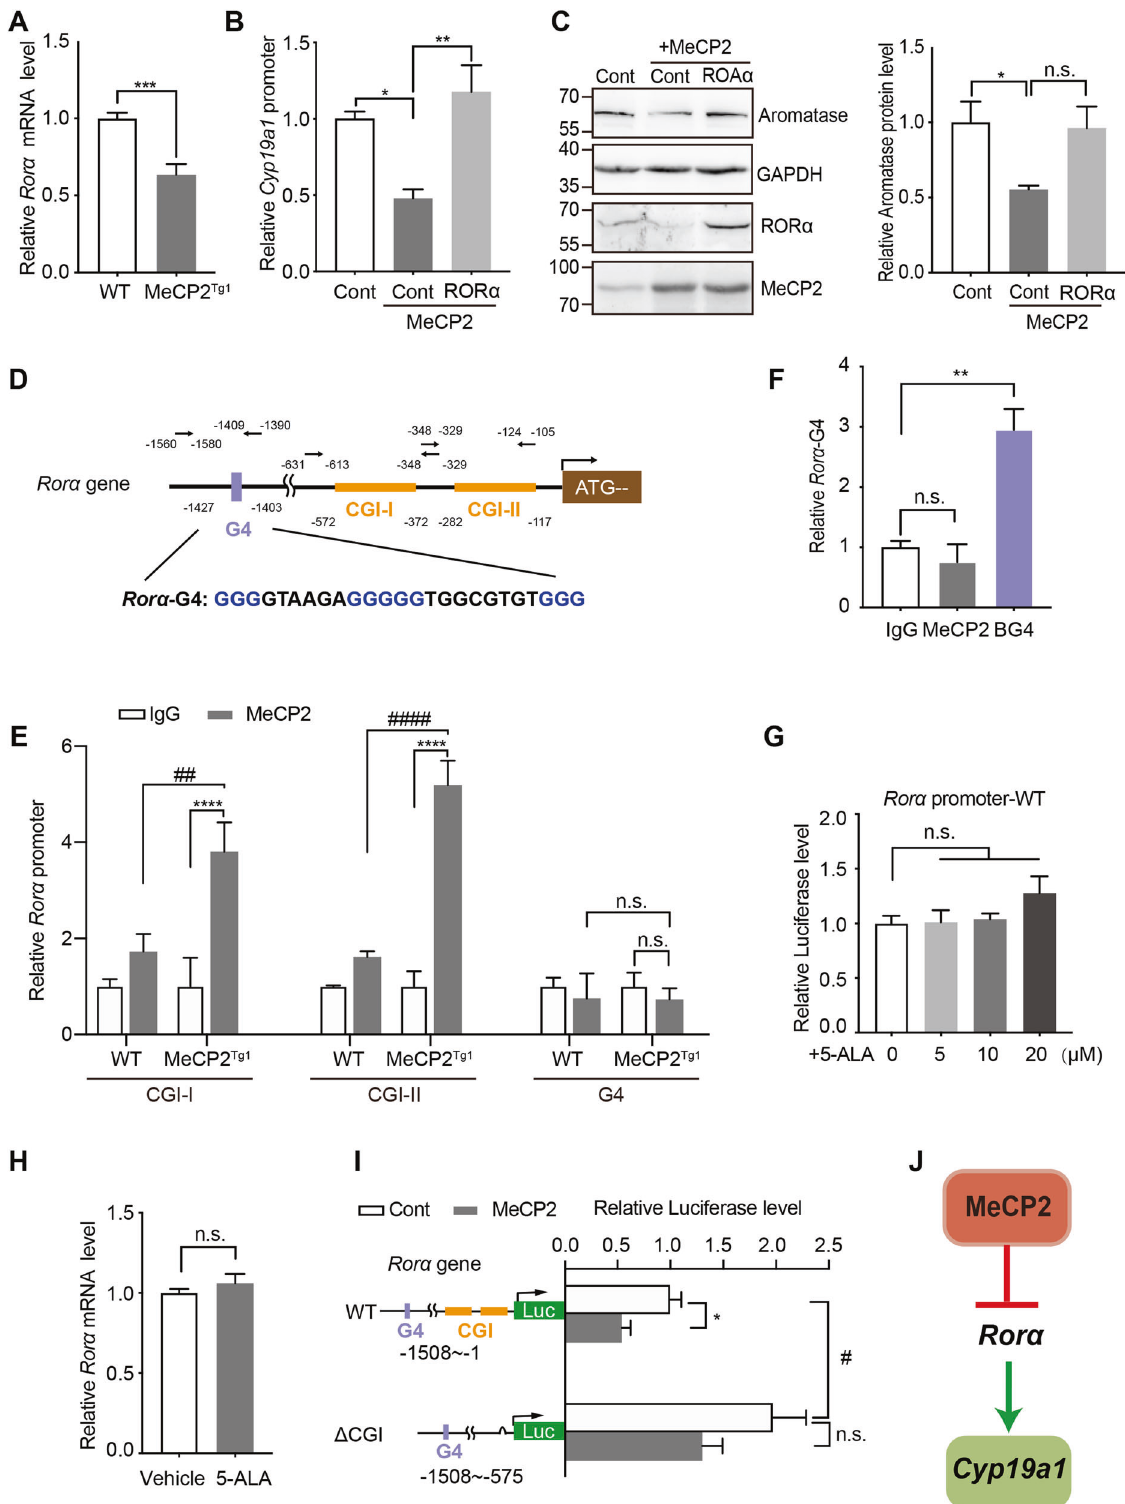
unknown. We roughly screened potential genes which might form G-quadruplex structures regulated by MeCP2 and compared the genes regulated by MeCP2 with the genes that contained consensus putative G-quadruplex sequences [38], about 40% (1034/2558) of MeCP2-regulated genes overlapped with the genes that contained PQSs (Fig. S8). Furthermore, the human genes contained PQSs in